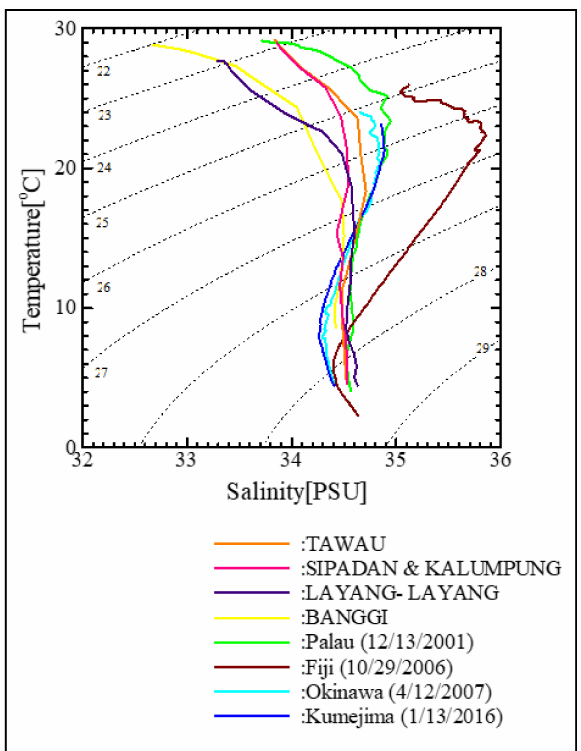
Figure 6. Deep seawater temperature–salinity profiles of Tawau, Sipadan, Pulau Kalumpang, Pulau Layang-layang and Pulau Banggi were compared with those of Palau, Fiji, Okinawa and Kumejima (contour (dotted line) represents the density ( σ t) (kg/m 3 )). These data were obtained from the online Japan Oceanographic Data Center